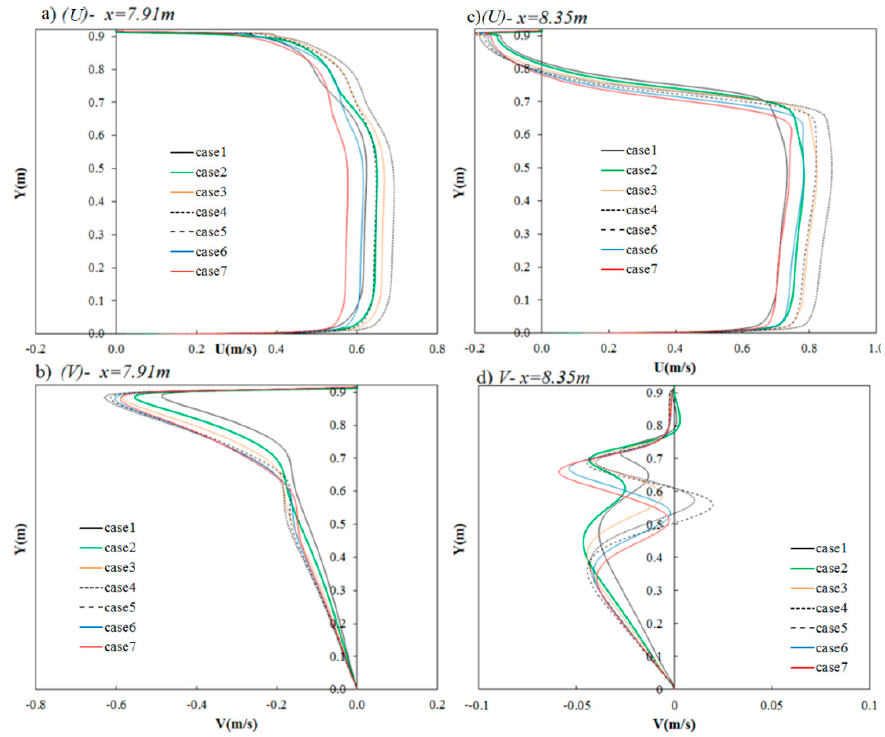
Figure 6. The comparison of velocity components at transverse planes a) U at x = 7.91, b) V at x = 7.91, c) U at x = 8.35m, and d) V at x = 8.35m.